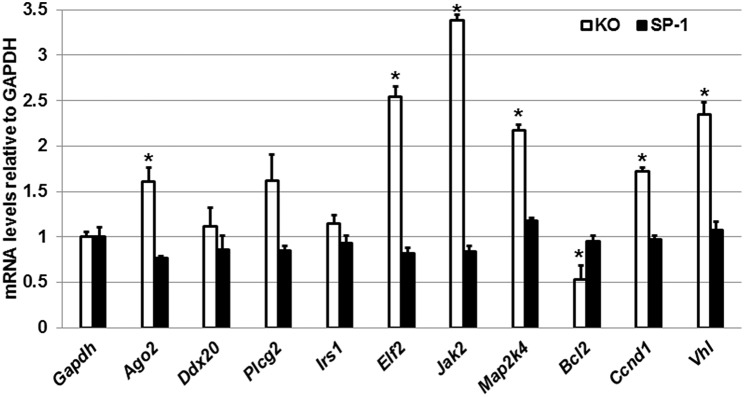
Effect of OxS in the T2C transcriptome of males. mRNA levels of Gapdh, Ago2, Ddx20, Plcg2, Irs1, Elf2, Bcl2, Jak2, Map2k4, Blc2, Ccnd1, and Vhl genes shown to be targeted by the T2C miRNome were measured in KO and SP-A1 male mice 4 h post O3 exposure. mRNA levels were measured by qRT-PCR and normalized to Gapdh. In KO the Jak2, Elf2, Vhl, Mapk2, Ccnd1, and Ago2 were significantly upregulated by 3.4-, 2.5-, 2.3-, 2.2-, 1.7-, and 1.7- fold (p < 0.05), respectively, while the Bcl2 was significantly downregulated by 0.5-fold. The levels of those mRNAs did not change in the SP-A1 mice. *means p < 0.05.